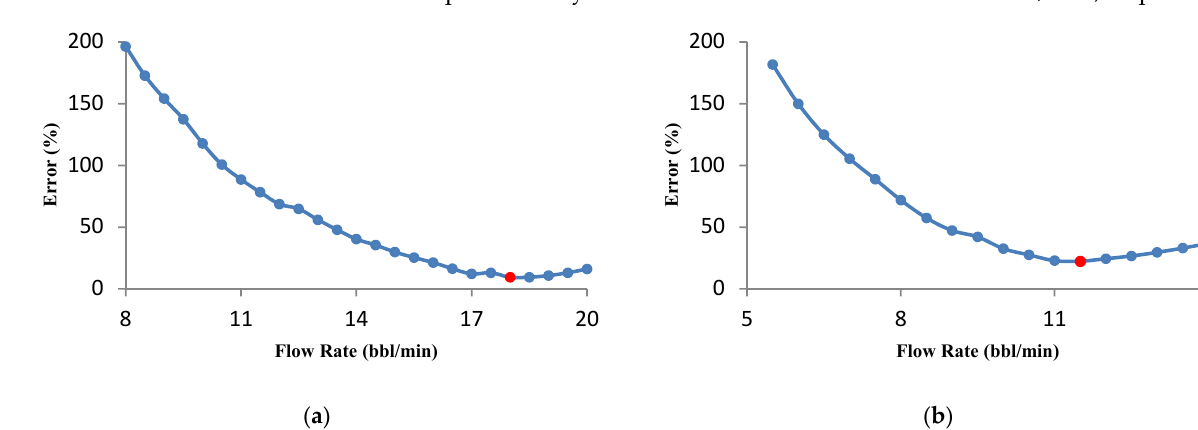
Figure 10. The influence of formation permeability on the optimal injection flow rate for a 500 bbl Acid Volume. ( a ) K = 0.001 md and ( b ) K = 0.1 md.